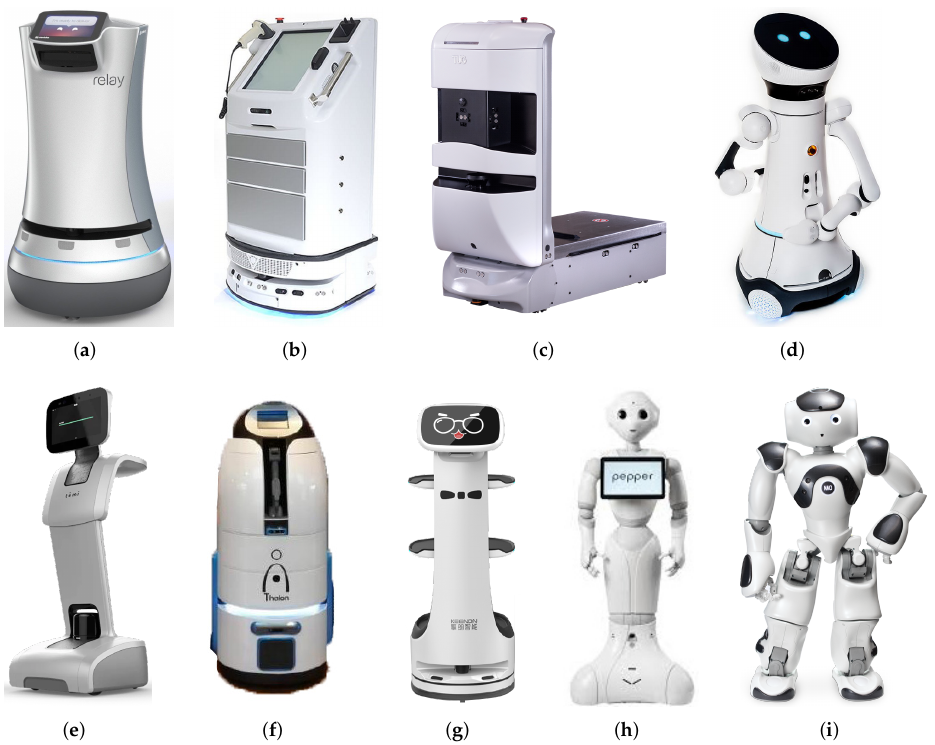
Figure 1. Robots: ( a ) Savioke [13] ( b ) Vecna QC Bot [14] ( c ) Aethon TUG [15] ( d ) Care-O-bot 4 [16] ( e ) Temi [17] ( f ) Thalon [18] ( g ) Dinerbot-T8 [19] ( h ) Pepper [20] ( i ) Nao